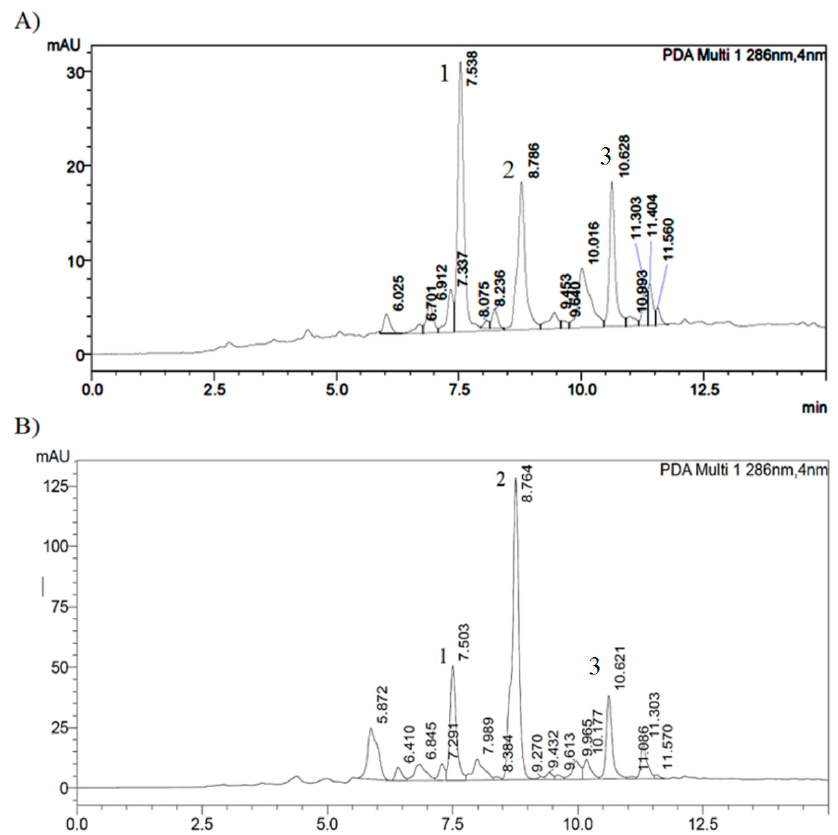
Figure 5. C-18 Reversed-phase HPLC chromatograms of ( A ) Myoporum insulare resinous leaf extract and ( B ) bee leg propolis extract. Compounds 1 – 3 are labeled. The gradient HPLC analysis was carried out using Shimadzu UFLC with a Hewlett Packard Column, NUCLEOSIL 100C18, 5 μ m, 4 mm × 125 mm, eluted with mobile phase, consisted of methanol (phase A), and methanol: water: acetic acid (40:59.8:0.2) (phase B), detected at 286 nm with a UV-Vis detector Shimadzu SPD-20A.